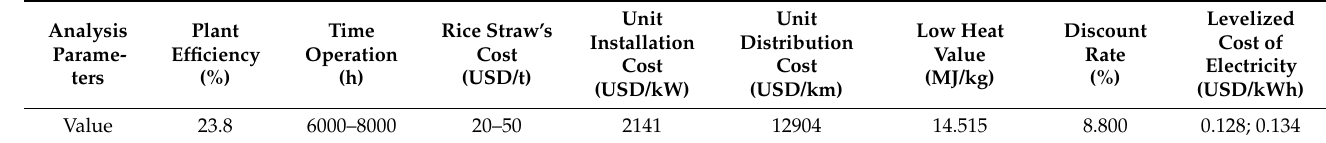
Table 6. Parameters for